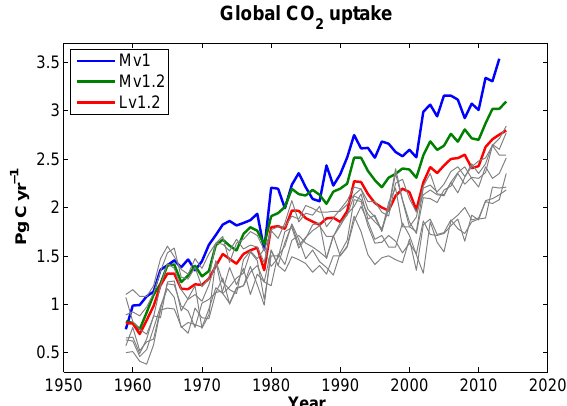
Figure 21. Globally integrated annual ocean carbon sink flux 1959– 2014 for Mv1 (blue line), Mv1.2 (green), and Lv1.2 (red) forced by the NCEP-C-IAF data set. Thin grey lines indicate the ocean car- bon sink fluxes calculated by the models used in Le Quéré et al. (2015): NEMO-PlankTOM5 (Buitenhuis et al., 2010), NEMO- PISCES (LSCE version, Aumont and Bopp, 2006), CCSM-BEC (Doney et al., 2009), MPIOM-HAMOCC (Ilyina et al., 2013), NEMO-PISCES (CNRM version, Séférian et al., 2013), CSIRO (Oke et al., 2013), and MITgcm-REcoM2 (Hauck et al.,